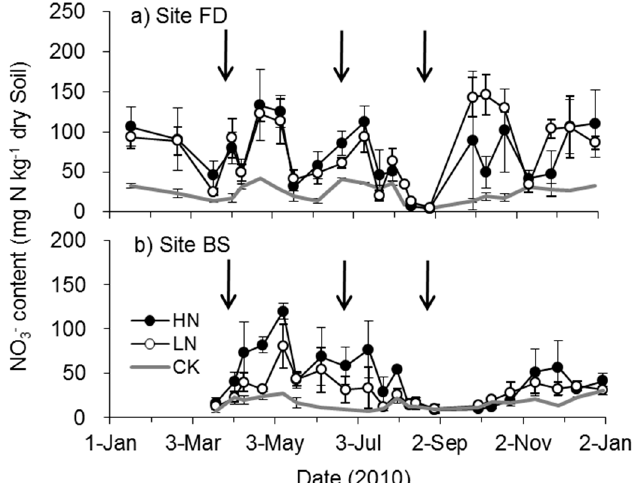
Figure 4. Seasonal dynamics of soil NO 3 − content (mg N kg − 1 ) across the sampling sites and treatments in 2010. ( a ) Fertilizer ditches; ( b ) Bare soil; Data points indicate the mean of the three replicates; error bars indicate the standard error (SE). Black arrows indicate nitrogen fertilizer applications.